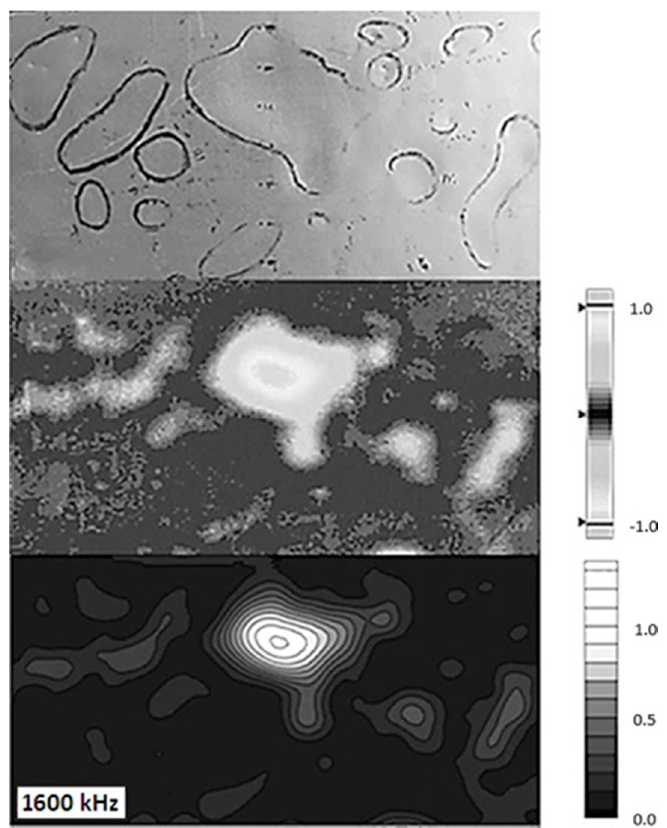
Figure 5. Damage region ( top ); 3D scanning deviation map ( middle ); 1600 kHz ECT contour map ( bottom ).